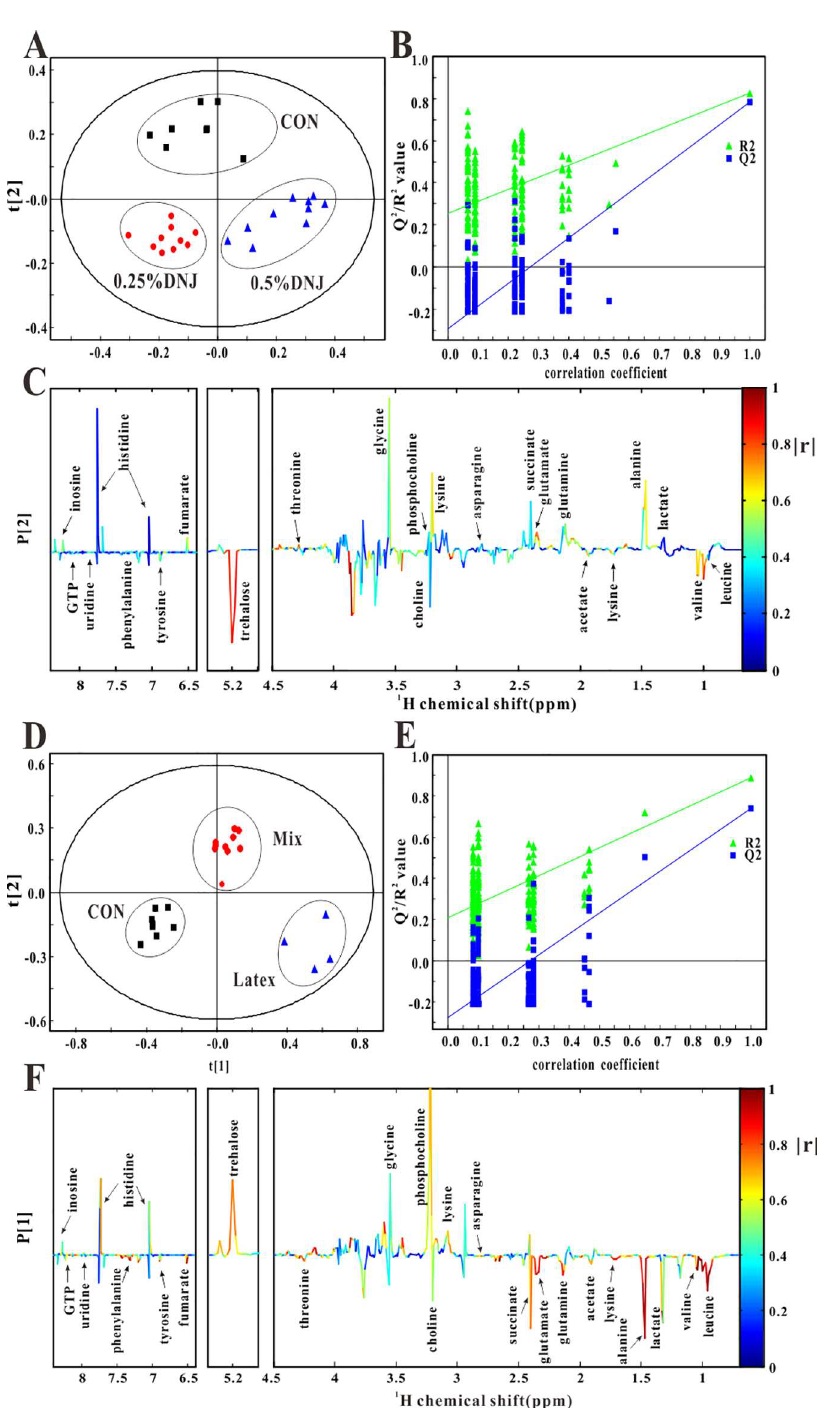
Fig 3. Results of partial least square-discriminant analysis (PLS-DA) of 1 H NMR spectra of midgut samples. PLS-DA score plots (A) based on 1 H NMR spectra of midgut extracts from Eri silkworms of the 0.25% DNJ group, 0.5% DNJ group, and control group (R 2 X = 0.424, R 2 Y = 0.84, Q 2 = 0.768, black square: control group, red circle: 0.25% DNJ group, blue triangle: 0.5% DNJ group), validation plot (B) and coefficient- codedloadingplots (C). PLS-DA score plots (D) basedon 1 H NMR spectra of midgut extracts from Eri silkworms of the latex group, mixture group, and control group (R 2 X = 0.518, R 2 Y = 0.922, Q 2 = 0.828, black square: control group, red circle: mixture group, bluetriangle: latex group), validation plot (E) and coefficient- codedloadingplots (F).